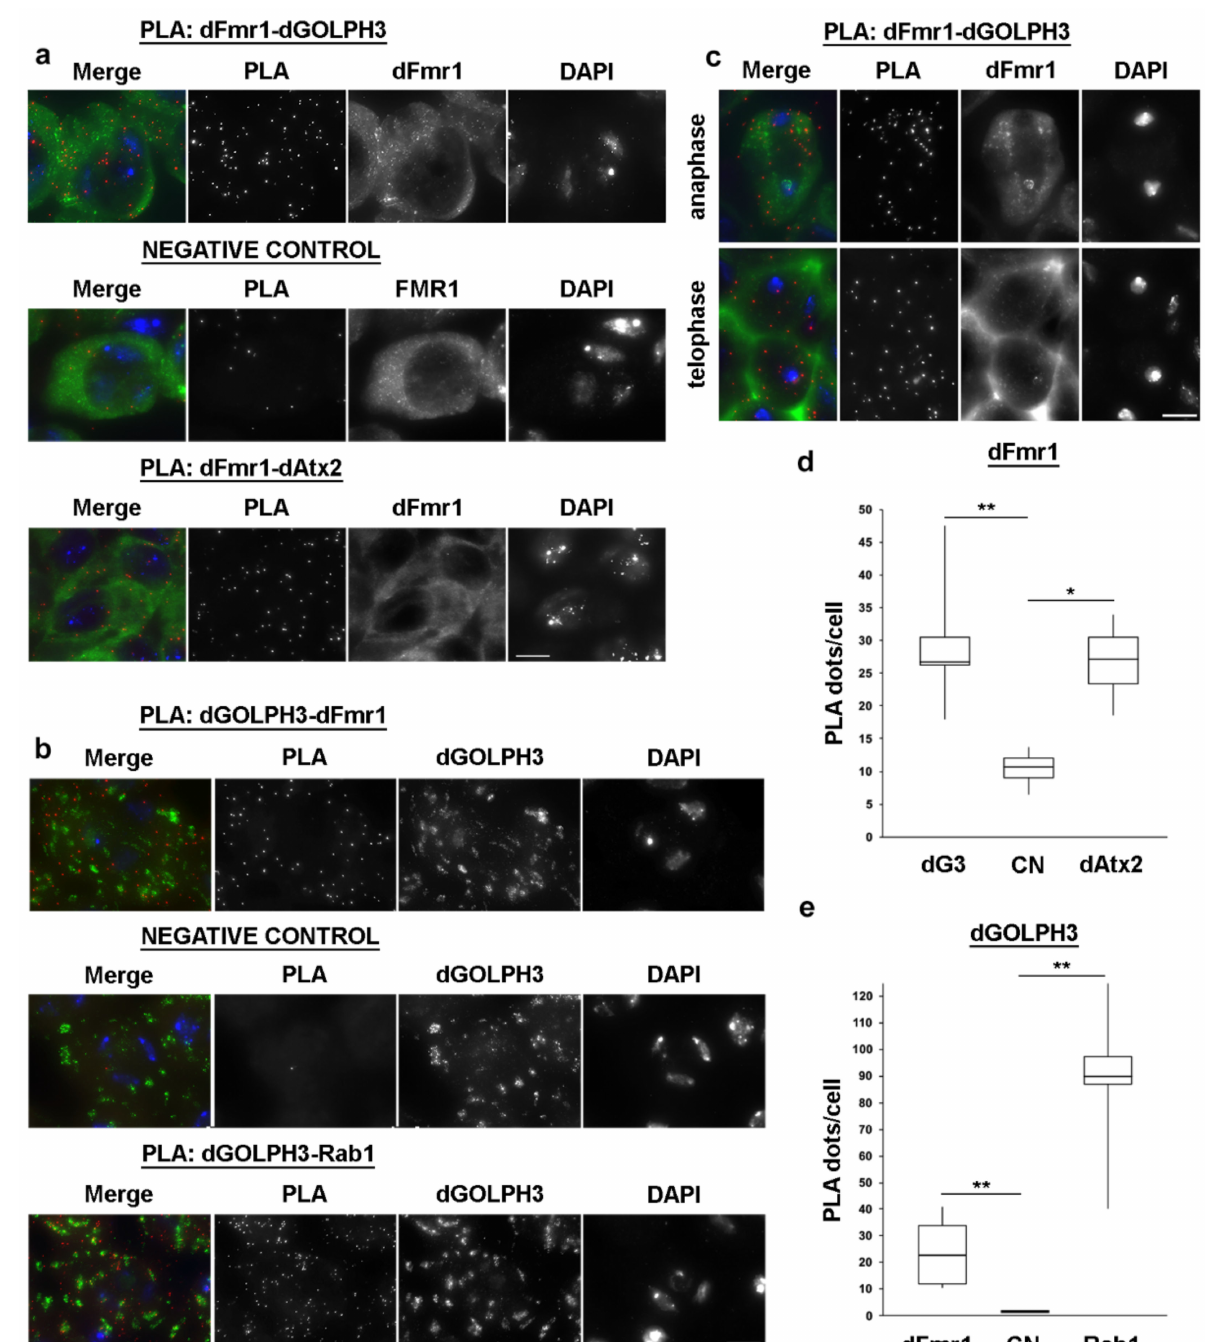
Figure 8. dFmr1 interacts with dAtx2 and dGOLPH3 in primary spermatocytes. ( a , b ) Proximity ligation assay (PLA) to visualize dFmr1-dGOLPH3 and dFmr1-dAtx2 interactions in premeiotic spermatocytes. In negative control primary anti-GOLPH3 ( a ) or anti-dFmr1 ( b ) antibodies were omitted. dGOLPH3-Rab1 interaction was used in positive control experiments. ( c ) PLA to visualize dFmr1-dGOLPH3 interaction in dividing spermatocytes. ( d , e ) Quantification of the PLA signals per cell was obtained as described in Materials and Methods. The box plots show the number of PLA dots per cell in dFmr1-dGOLPH3, dFmr1-dAtx2 and dGOLPH3-Rab1compared to negative controls (CN). dG3, dGOLPH3. A total of 50 cells were randomly selected from images taken in 5 independent experiments. Statistic significant differences are * p < 0.05; ** p < 0.01 (Mann-Whitney test). Bars, 10 µ